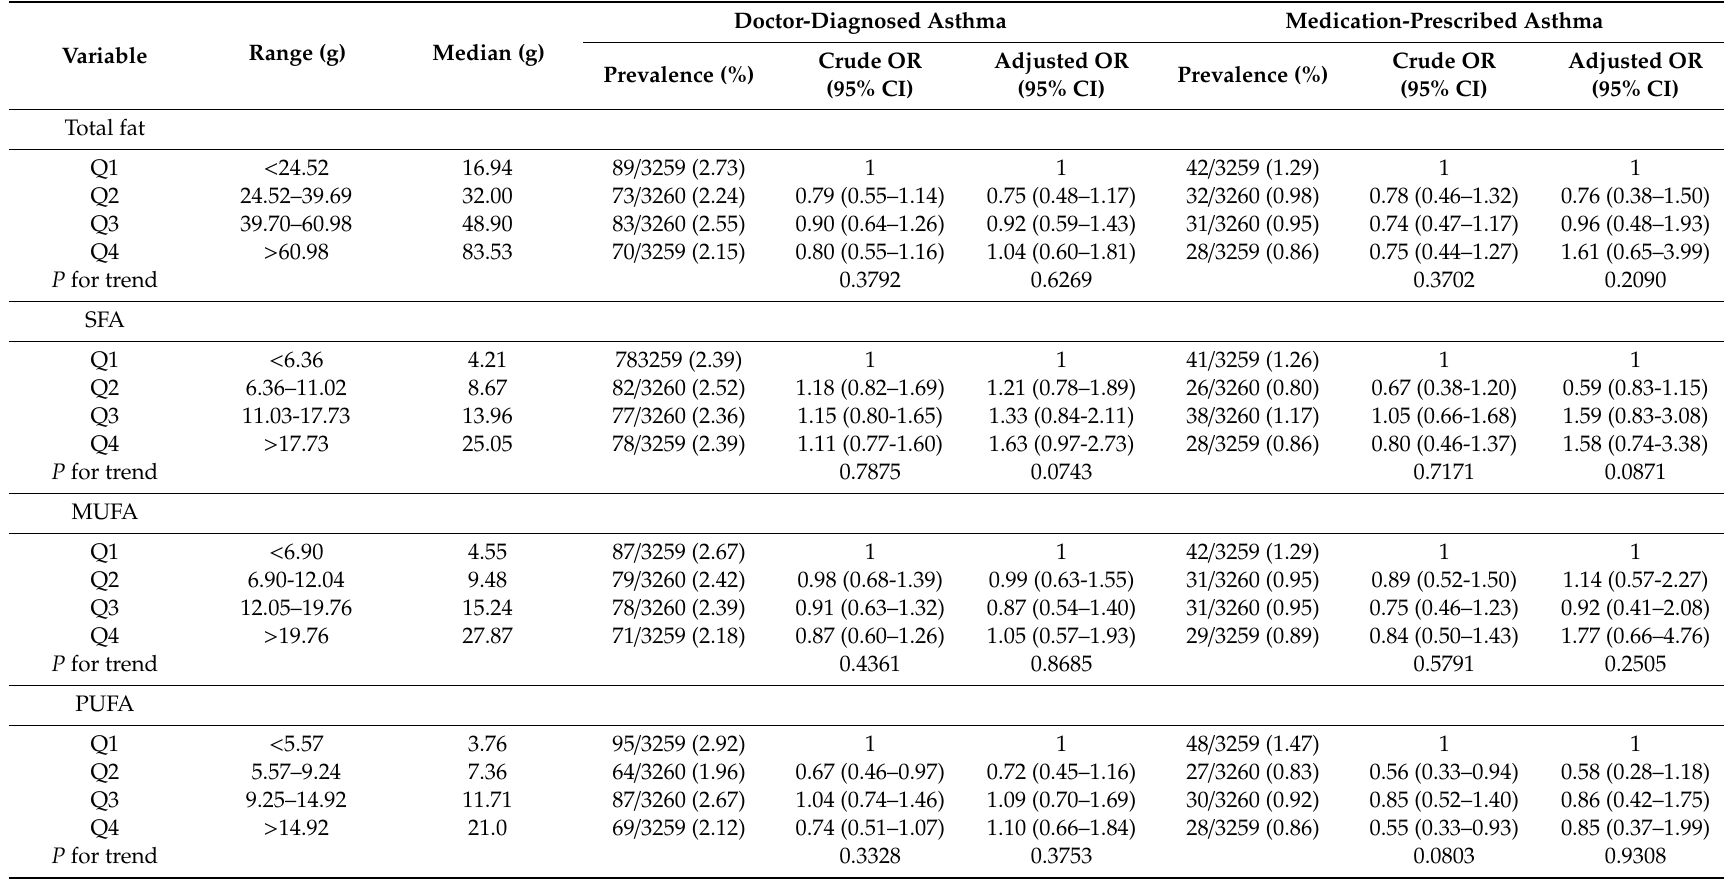
Table 4. Association between specific types of dietary fat and